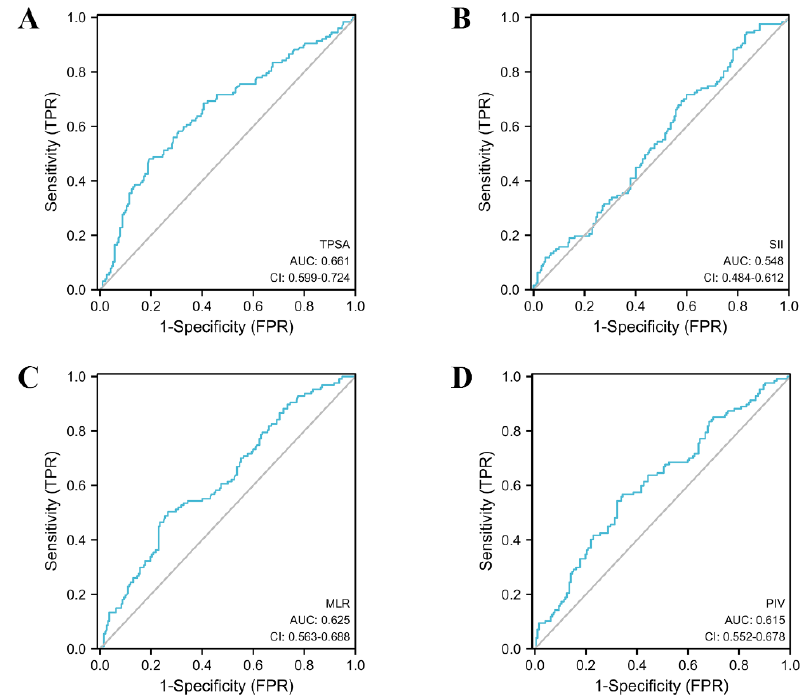
Figure 3. The AUC curves of TPSA and inflammatory markers in clinically significant prostate cancer. ( A ): The AUC curves of TPSA; ( B ): The AUC curves of SII; ( C ): The AUC curves of MLR; ( D ): The AUC curves of PIV.